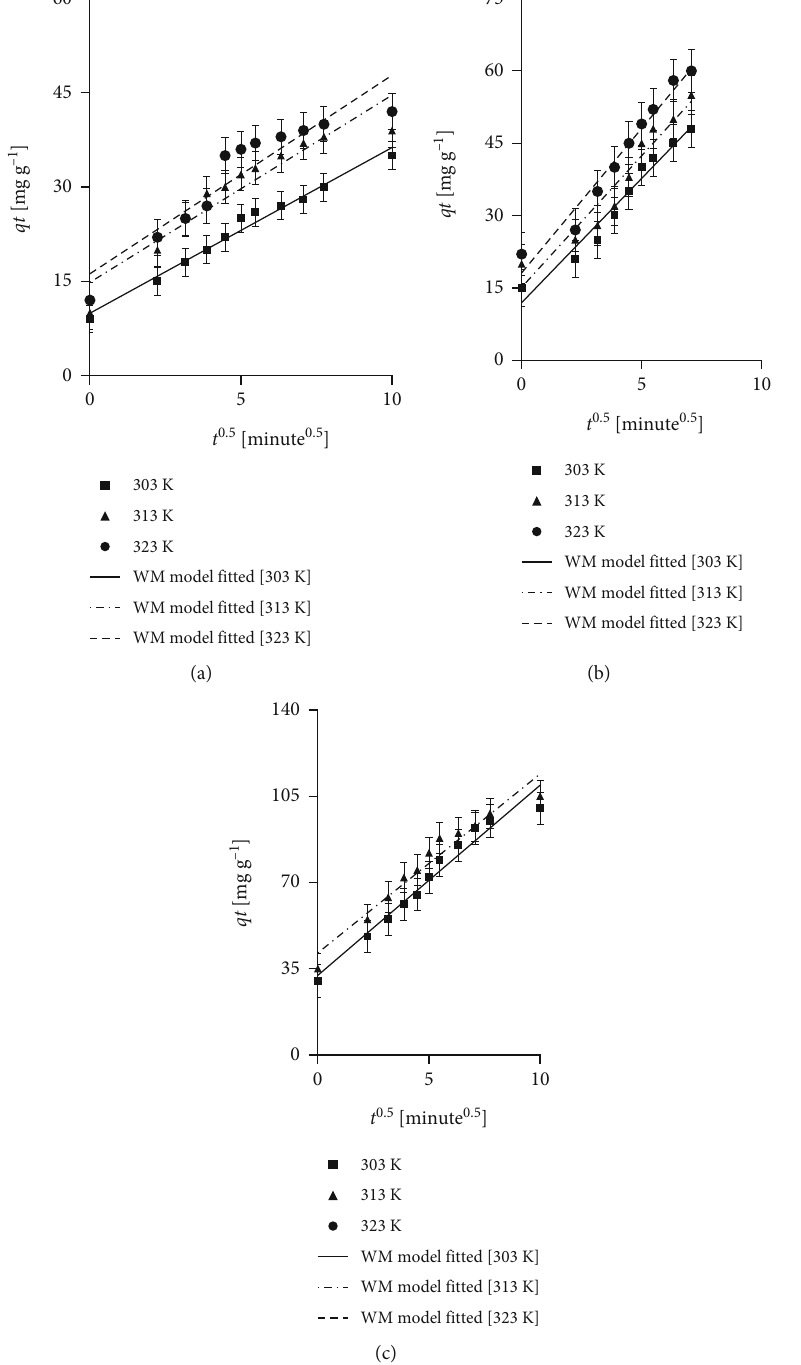
Figure 17: Data kinetics fi t of Weber- Morris model with CV concentrations of (a) 50 ppm, (b) 100 ppm, and (c) 200